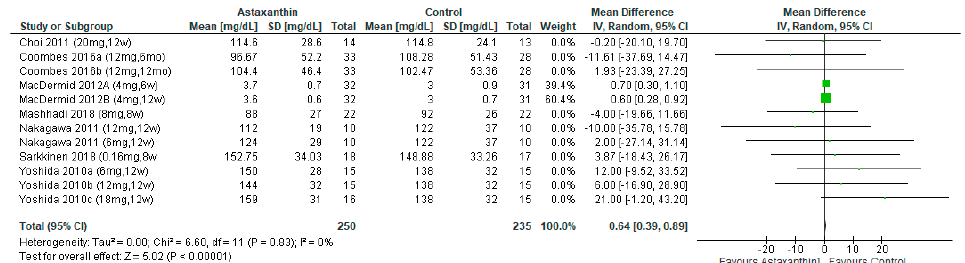
Figure 8. Forest plot of the effect of astaxanthin on low-density lipoprotein cholesterol [26–32]. Bold means total data.